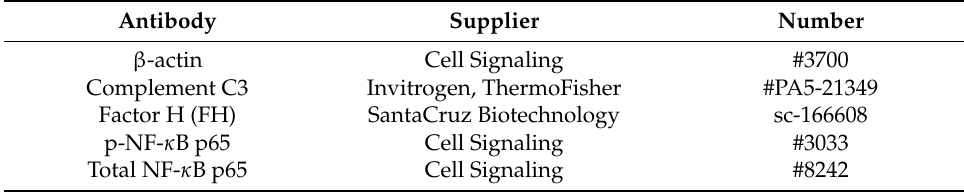
Table 2. List of primary antibodies used in this